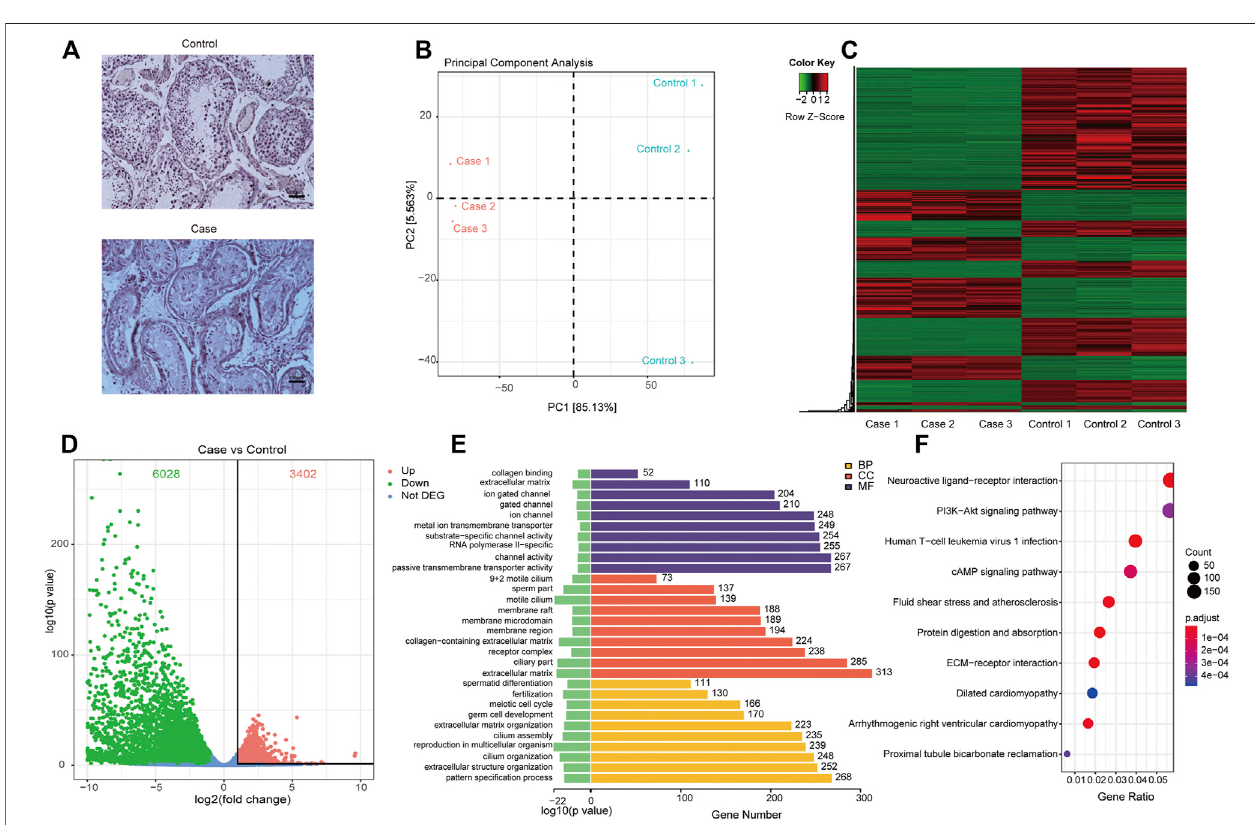
FIGURE 2 | Differentially expressed genes and their related functions. (A) H&E staining of testicular tissue; (B) principal component analysis of expressed genes distinguishcasesandcontrols; (C) heatmapandphylogenetictreeofdifferentiallyexpressedgenes; (D) thedifferentiallyexpressedgenes.Reddotsindicatesigni fi cantly upregulated genes in cases. Green dots indicate signi fi cantly downregulated genes in cases and that the genes were not signi fi cantly differentially expressed in cases wereindicatedby blue dots; (E) gene ontology functionalenrichmentofsigni fi cantly differentiallyexpressed genes; (F) ,KEGG functionalenrichmentof signi fi cantly differentially expressed